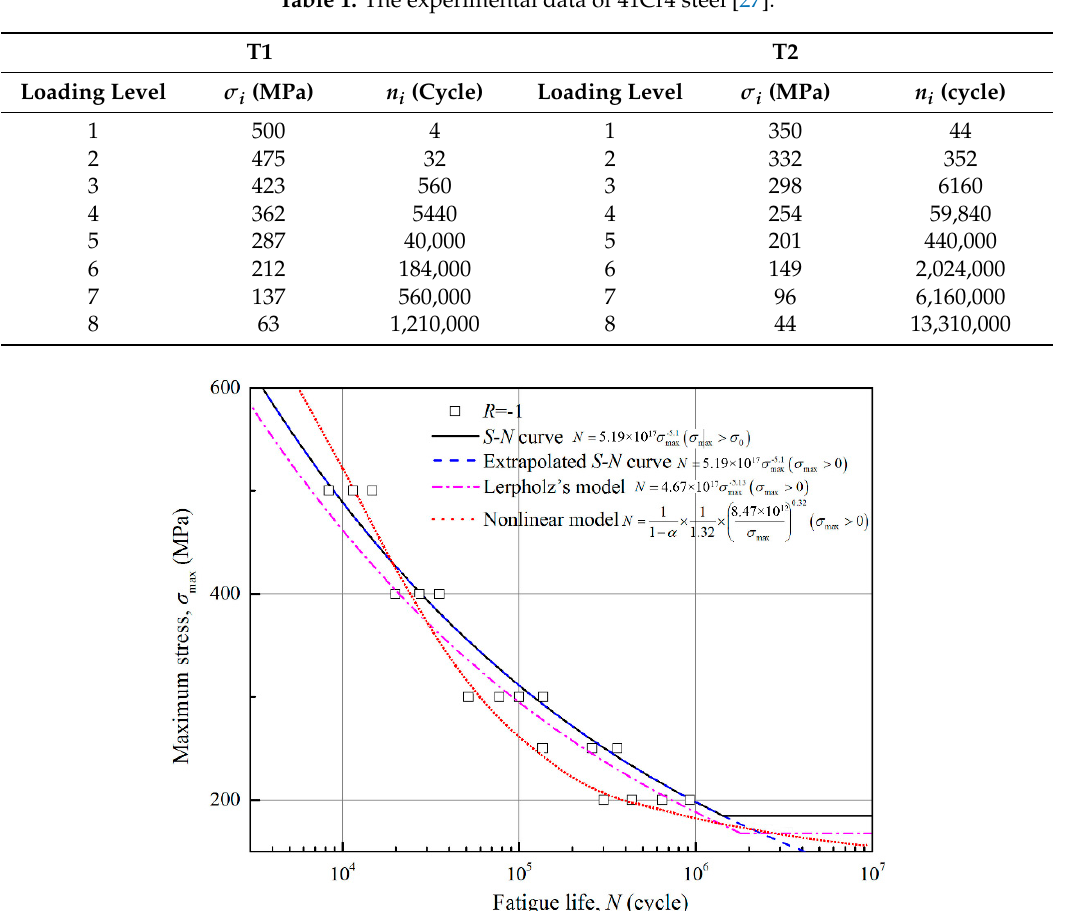
Figure 5. Fagitue model curves of 41Cr4 steel under R = − 1. Table 1. The experimental data of 41Cr4 steel [27].